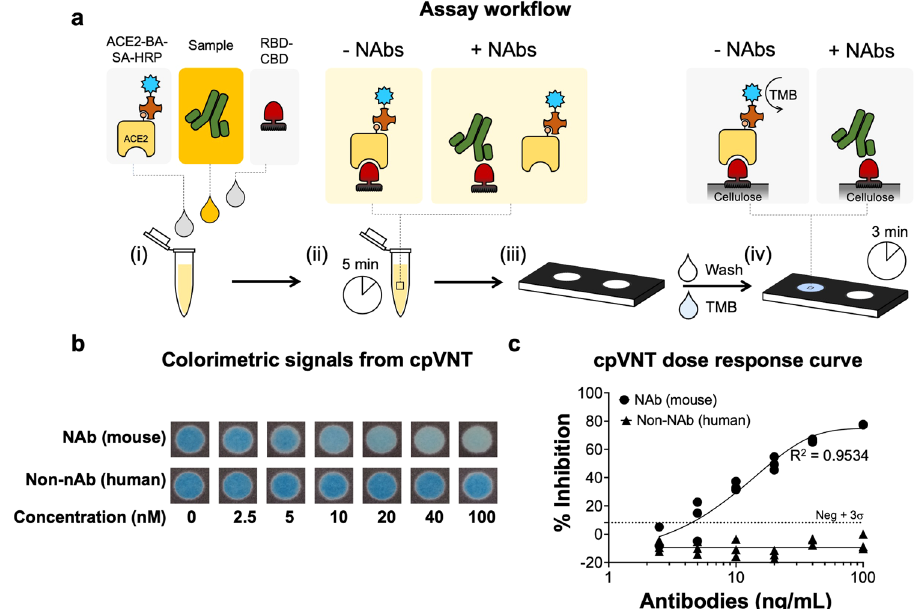
Fig. 2 Overview of work fl ow and signal analysis of cellulose pull-down VNT. a Schematic of working principle and work fl ow of cellulose pull-down VNT (cpVNT). (i) Un-diluted plasma is mixed with receptor binding domain (RBD) tagged to cellulose binding domain (RBD – CBD) and angiotensin-converting enzyme 2 receptor (ACE2) tagged to biotin and streptavidin horse-radish peroxidase (ACE2-BA-SA-HRP). (ii) The reaction is incubated for 5 min to allow neutralizing antibodies (Nabs)/RBD – CBD or ACE2-BA-SA-HRP/RBD – CBD complex formations. (iii) The mixture is applied on the cellulose-based vertical- fl ow device. (iv) Washing solution and ready-to-use 3,3 ′ ,5,5 ′ -tetramethylbenzidine (TMB) substrate solution are sequentially applied to the device. Colorimetric reaction is allowed to develop for 3 min. Signals were captured using camera. b Images of cpVNT test results at different concentrations of mouse anti-SARS-CoV-2 neutralizing antibodies and human anti-RBD non-neutralizing antibodies. c Plots of inhibitory percentages derived from cyan intensity signals. Limit of detections (LOD) were determined using mean + 3 standard deviation (SD) formula and represented as the dotted lines. All data were represented as mean ± SD. Each data points were performed in triplicates. 4 Parameters logistic model was used to draw the fi tted curve with R 2 value of